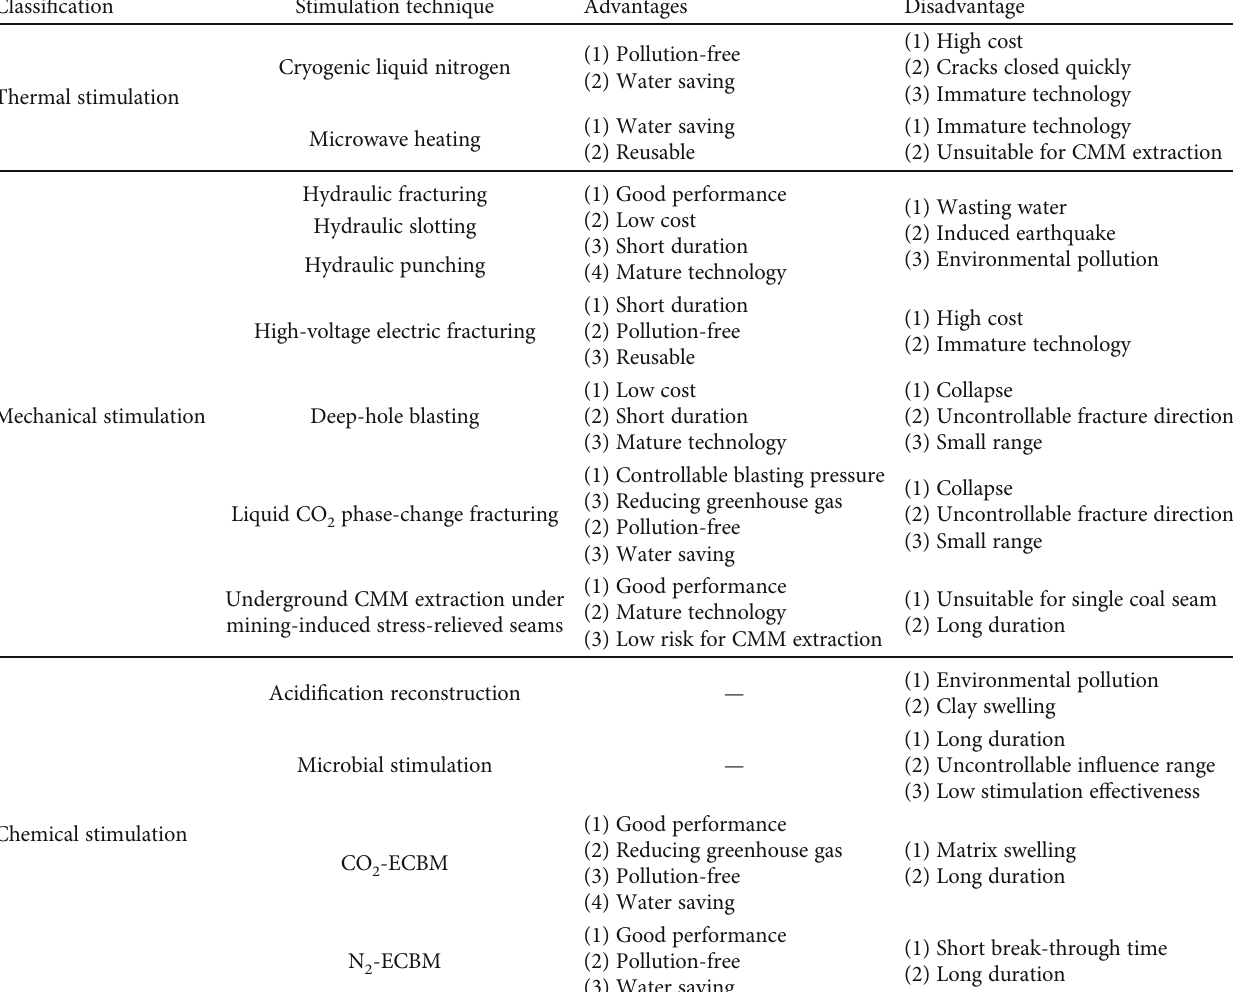
Table 3: Advantages and disadvantages of di ff erent stimulation techniques.